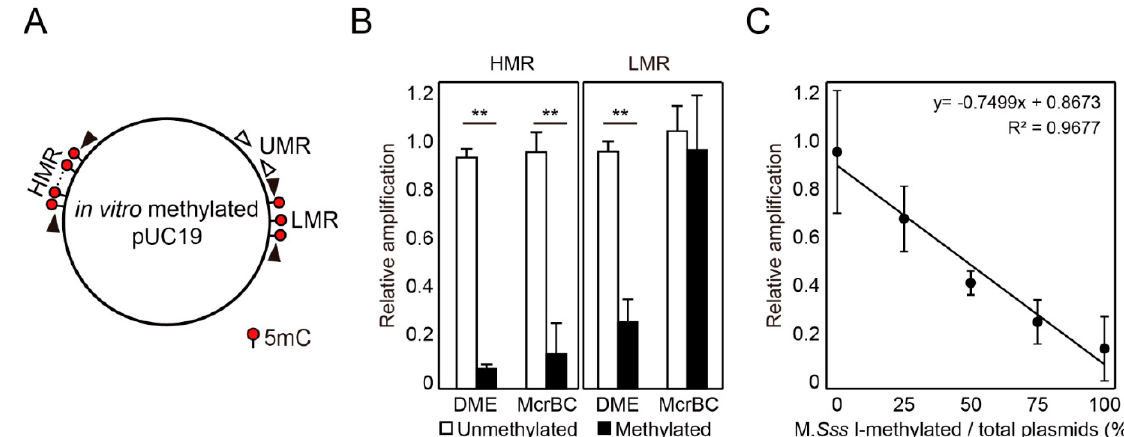
Figure 2. DME-qPCR analysis for quantification of the level of DNA methylation. ( A ) Schematic representation of the pUC19 plasmid with DMRs. For the heavily and low methylated regions (HMR and LMR), the pUC19 plasmid was in vitro methylated with M. Sss I and Hpa II methyltransferases, respectively, producing differentially methylated HMR (20 5mC sites) and LMR (three 5mC sites) regions. Differentially methylated HMR and LMR, along with unmethylated UMR as a control, were subjected to qPCR analysis with corresponding primers. HMR, heavily methylated region; LMR, low methylated region; UMR, unmethylated region. ( B ) Comparison between DME and McrBC treatments for quantification of DNA methylation. Following the enzyme treatment, HMR, LMR, and UMR were subjected to qPCR analysis with corresponding primer pairs. Relative amplification was calculated using the ∆∆ Ct method for unmethylated (white bar) and methylated (black bar) pUC19 plasmids normalized with the value obtained from UMR. ( C ) Relative amplifications for different ratios of methylated DNA by DME-qPCR. The percentage (x-axis) indicates the ratio of M. Sss I-methylated plasmids to the total plasmids in the reaction. Relative amplification values were obtained for HMR from DME-qPCR, and a regression line fitted to the observed data. The data represent the mean ± S.D. for three replicates ( B , C ). Asterisks indicate statistically significant differences between the unmethylated and methylated plasmids (**: p < 0.01; Student’s t -test).